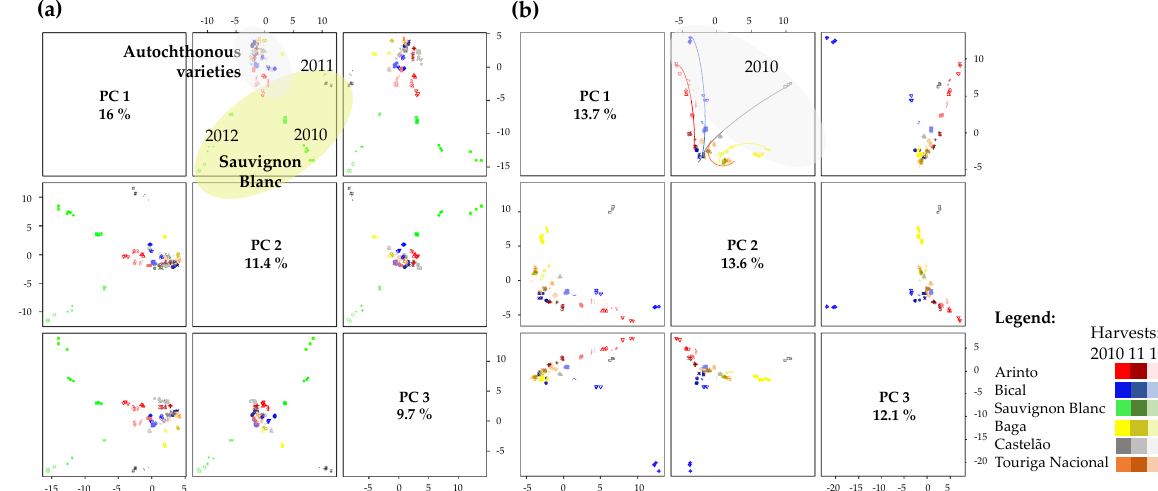
Figure 10. Pairwise scores plot for the top three PCs for joined data of ( a ) the six varieties under study and ( b ) for the five autochthonous Bairrada Appellation. Each grape variety was identified with a different color and the color gradient code corresponds to the different harvests under study. For each vineyard parcel, a different shape code was automatically displayed by the MetaboAnalyst software.